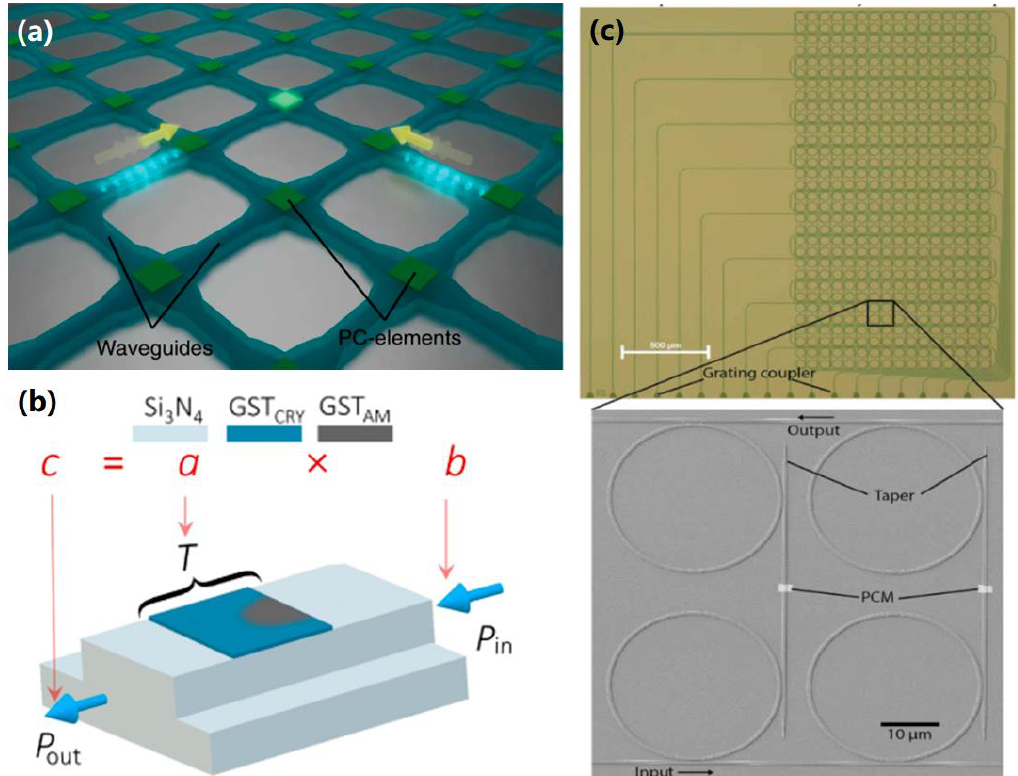
Figure 14. ( a ) Sketch of a waveguide crossing array illustrating the two-pulse addressing of individual phase-change cells. Only overlapping pulses provide sufficient power to switch a desired PCM-cell; ( b ) scheme of the multiplication of two scalars a and b, codified in the device transmittance T and in the energy of the read pulse Pin; ( c ) 16 × 16 cell photonic matrix memory showing optical micrograph of the memory cells (top) and SEM of a single cell within the array (bottom). (( a ) is reprinted with permission from [133]; ( b ) is reprinted with permission from [134], and ( c ) is reprinted with permission from [135].)